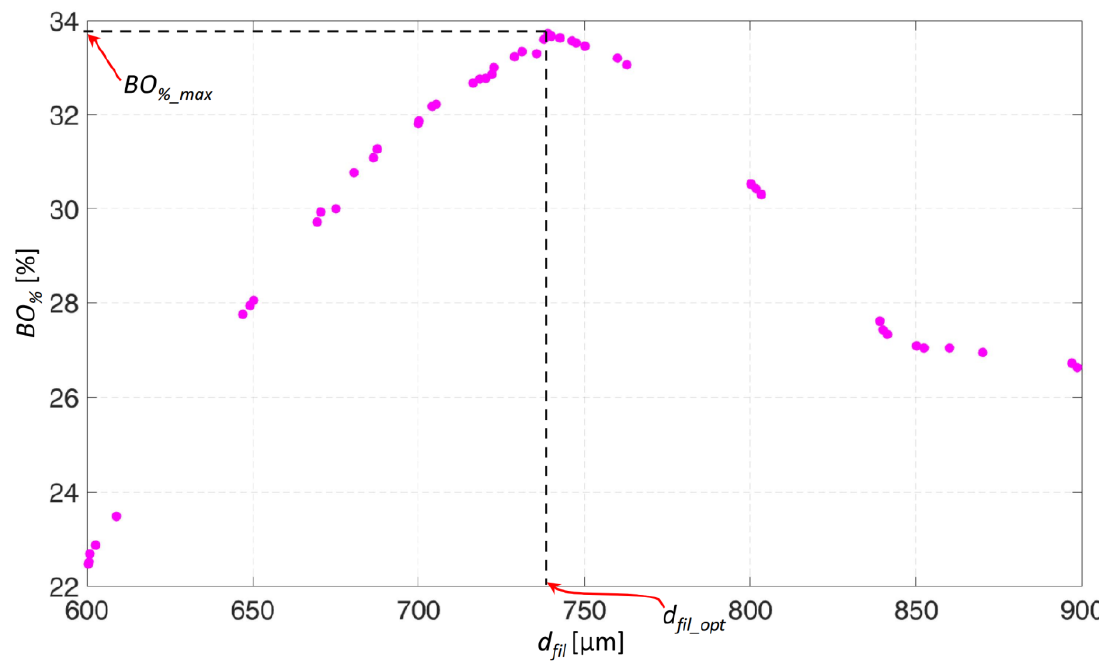
Figure 5. Typical values of BO % obtained in an optimization process for different values of d fil . In detail, the diagram refers to the case of D = 600 µm and p = 0.5 MPa.